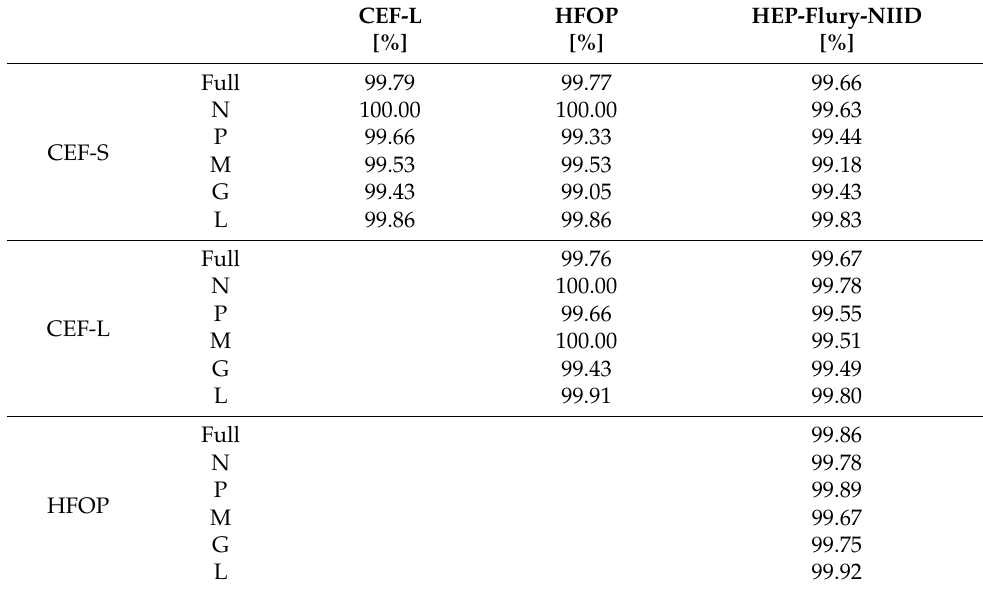
Table 3. Identity of PCECV-KMB-related